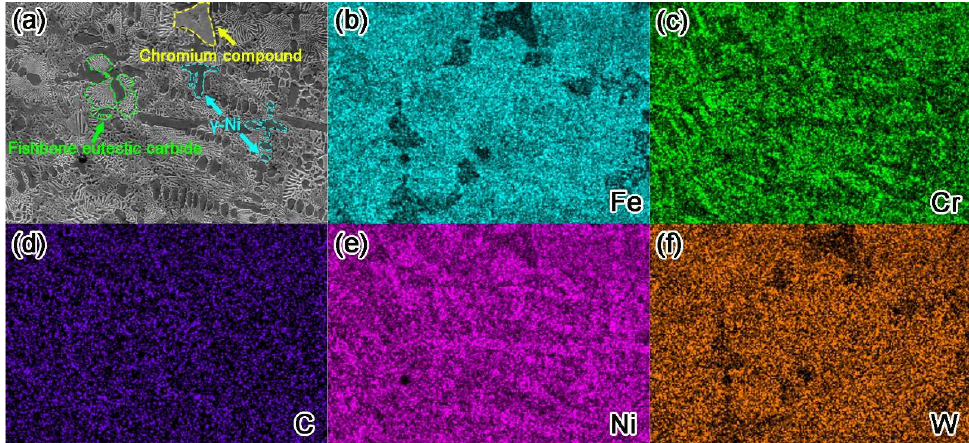
Figure 10. SEM image of the microstructure of the surfacing layer ( a ) and the corresponding energy dispersive spectroscopy (EDS) maps ( b – f ).